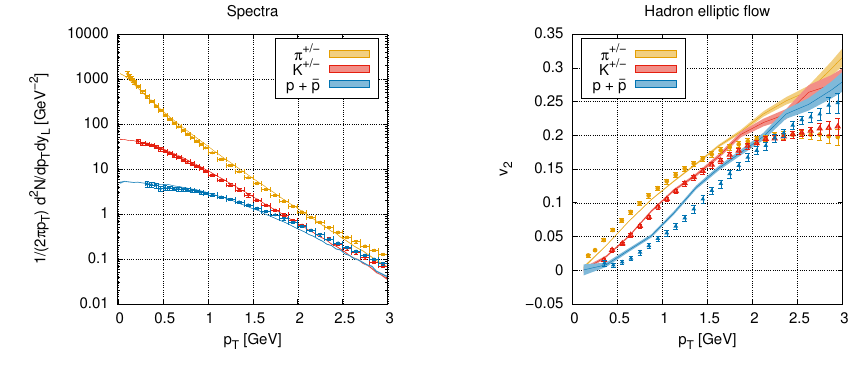
Figure 1. Left panel: Identified hadron spectra of π (orange curve), K (red line) and p + anti- p (blu curve) for PbPb collisons at √ s = 2 . 76TeV. Circle, triangles and square point are experimental data from ALICE collaboration taken from [21]. Right panel: elliptic flow v 2 for Pb + Pb collision at √ s = 2 . 76TeV of π , K , p for 20-30 % centrality cut and at mid-rapidity. Experimental data taken from